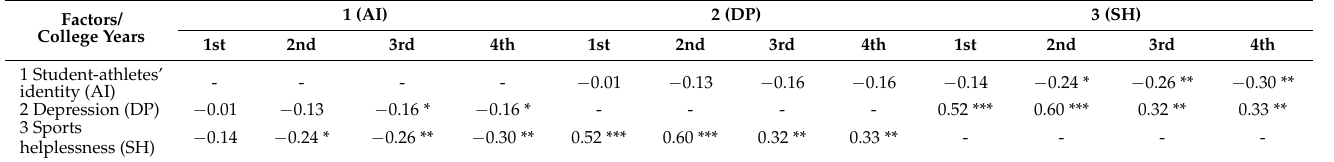
Table 3. Correlation coefficients between student-athlete’s identity with depression and sports helplessness.